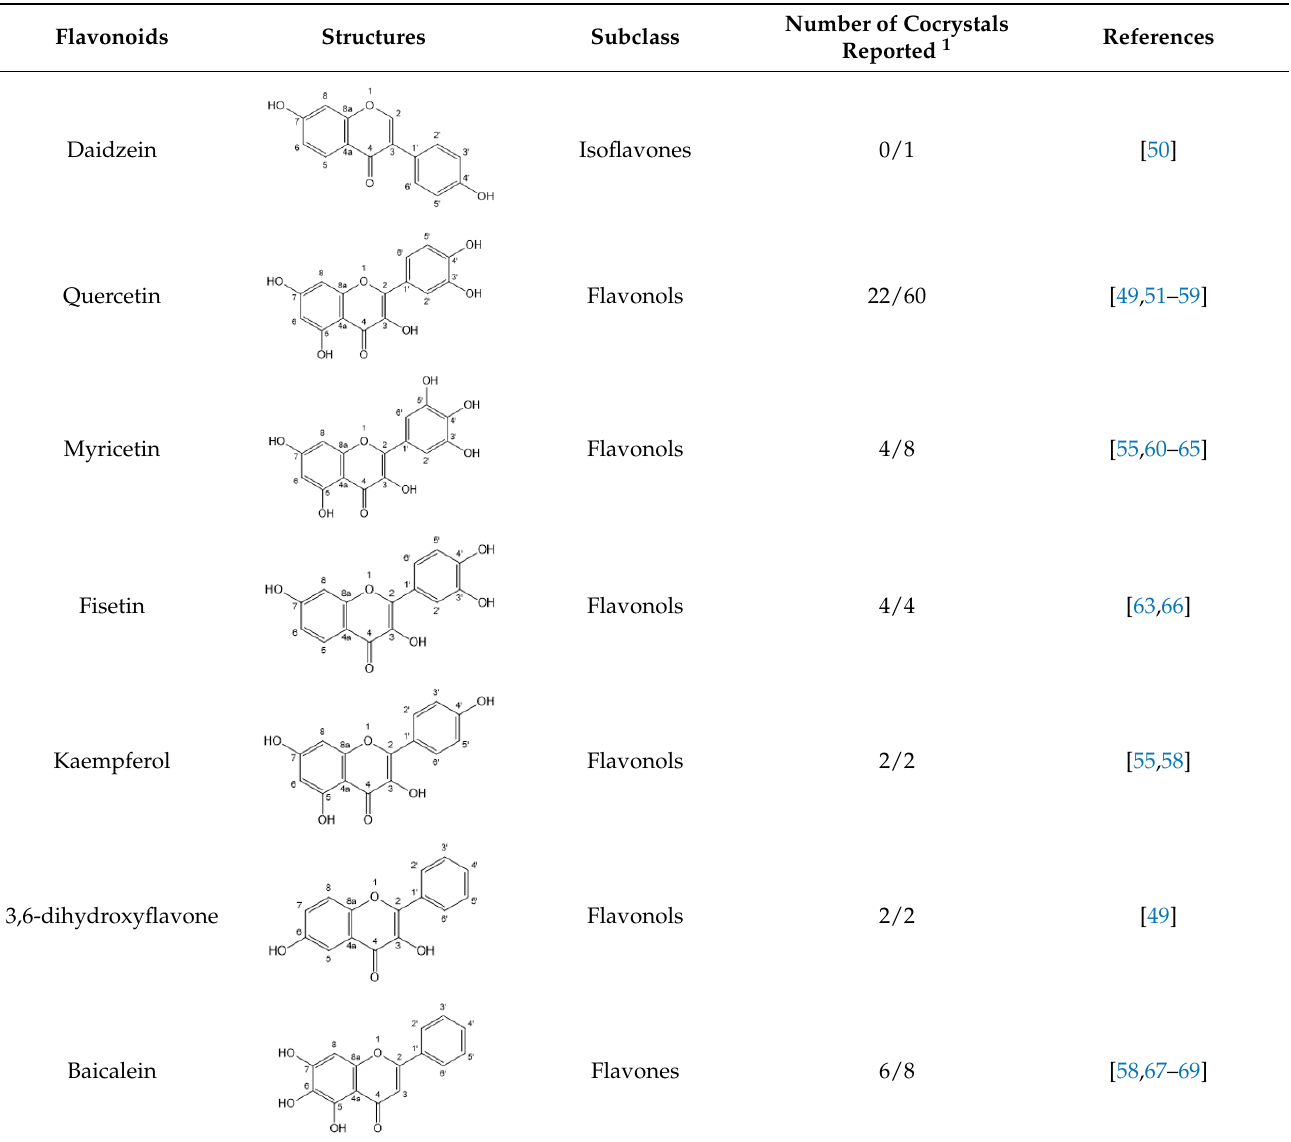
Table 1. Summary of reported flavonoid Table 1. Summary of reported flavonoid cocrystals. Table 1. Summary of reported flavonoid cocrystals. Table 1. Summary of reported flavonoid cocrystals. Table 1. Summary of reported flavonoid cocrystals. Table 1. Summary of reported flavonoid cocrystals. Table 1. Summary of reported flavonoid cocrystals.